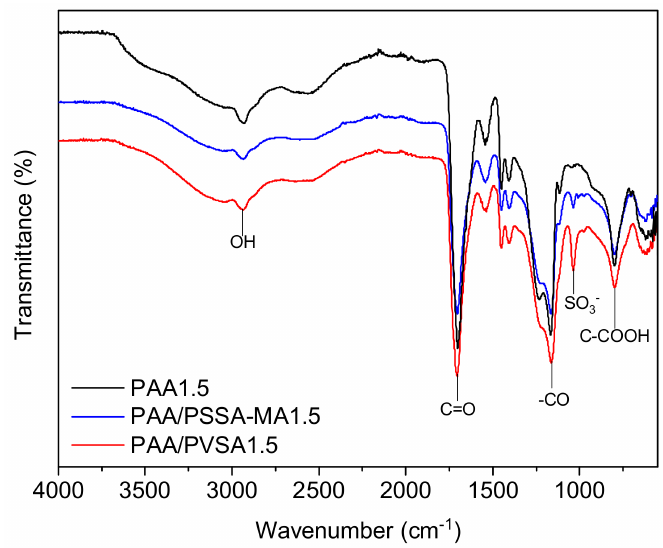
Figure 5. FTIR spectrum of PAA1.5, PAA/PVSA1.5,